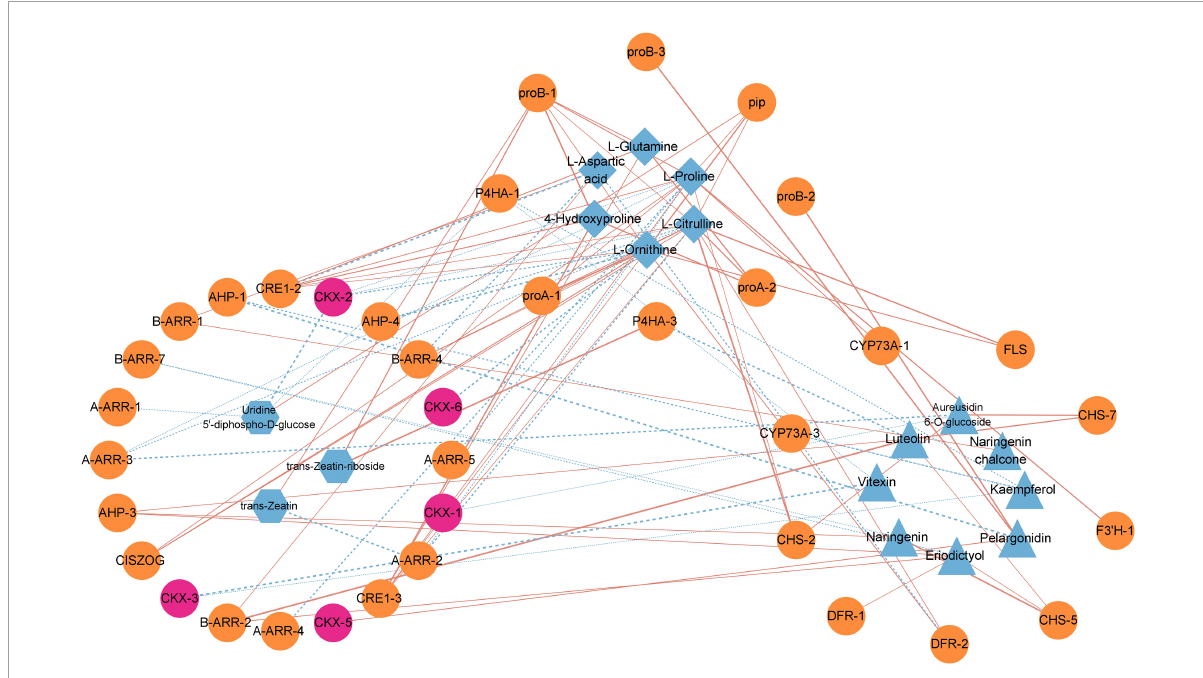
FIGURE6 Correlation analysis of flavonoid biosynthesis, arginine and proline metabolism, and zeatin biosynthesis pathways. Orange blocks represent genes, blue blocks represent metabolites, and pink blocks represent PcCKXs . Red line represents positive correlation and blue line represents negative